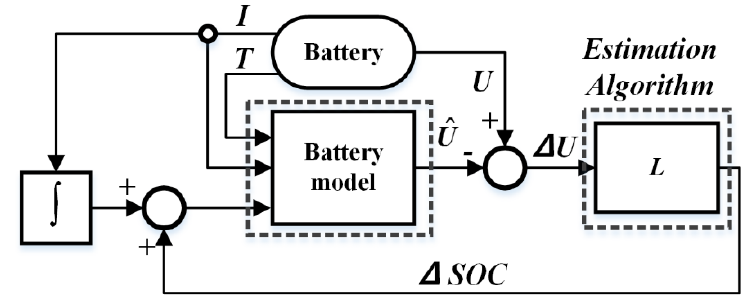
Figure 1. Framework of the model-based State of Charge (SOC) estimation methods.